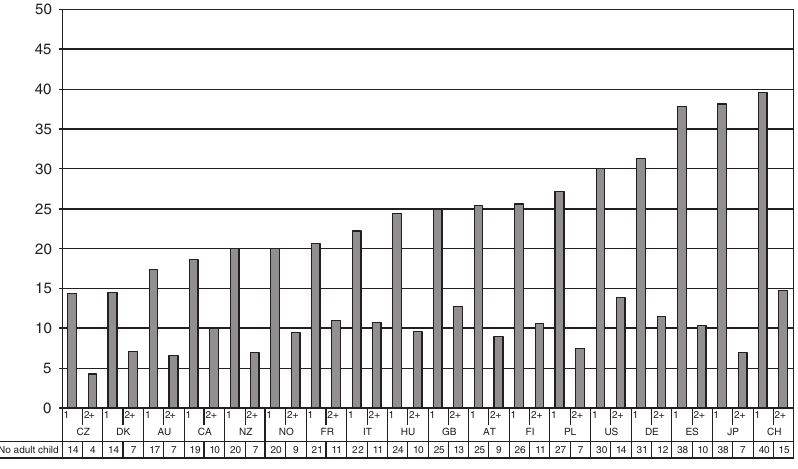
Figure 1. Proportion with no adult children by household structure (li v ing alone/2 (cid:3)